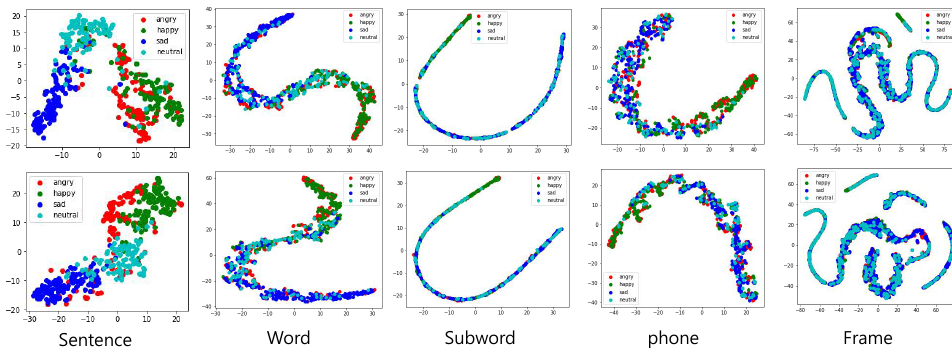
Figure 5. TSNE of priors (upper) and posteriors